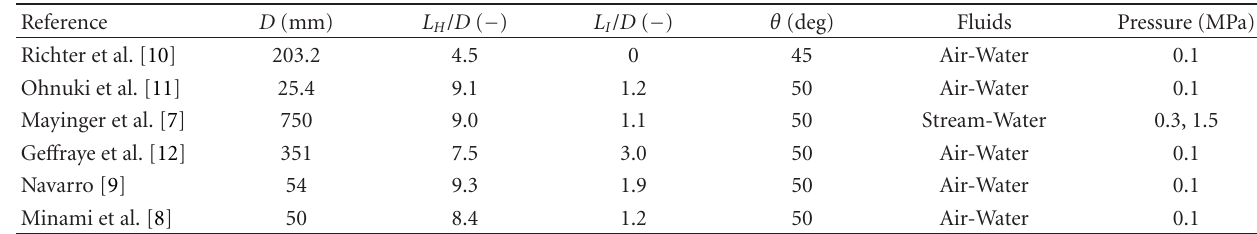
Table 1: Test section dimensions and